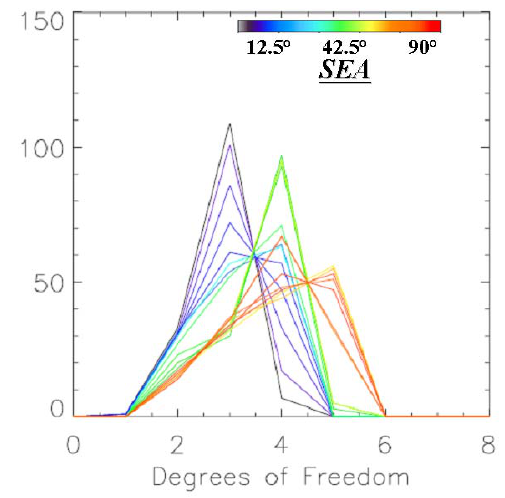
Fig. 2 Histogram for various scenarios (Y-Axis) of the number of DFS of reflectance Fig. 2. Histogram for various scenarios (y-axis) of the number of measurements for retrieval with different sun elevation angle (SEA) for a case with surface DFS of reflectance measurements for retrieval with different sun albedo spectra over soil. elevation angle (SEA) for a case with surface albedo spectra over soil.